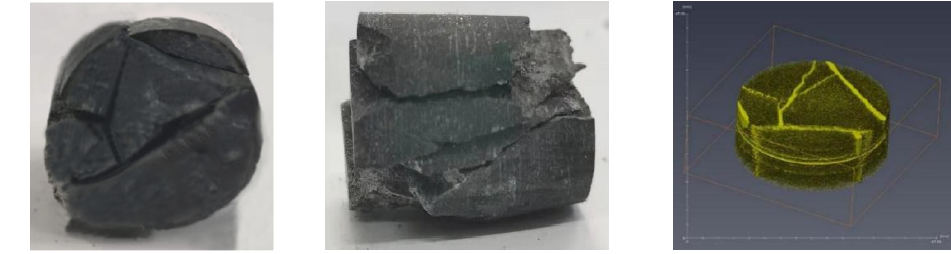
Figure 7. Complete failure result of mudstone and 3D image of fractures.